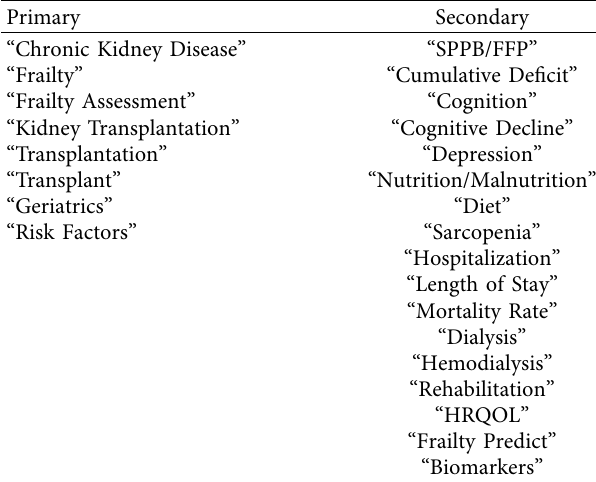
Table 1: Primary and secondary search